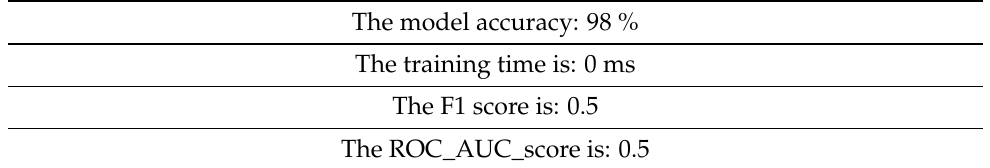
Table 3. Online Dataset SVM.